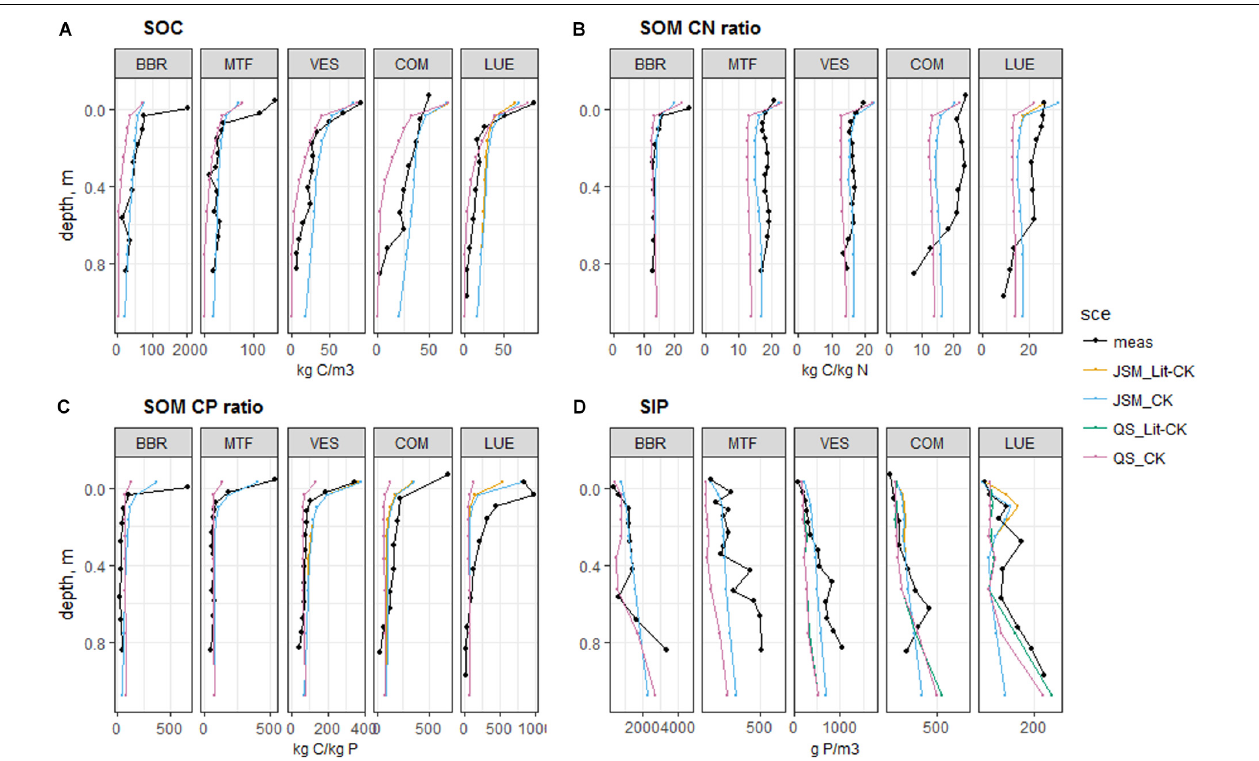
FIGURE 2 | Simulated and observed (A) SOC content, (B) C:N ratio in SOM, (C) C:P ratio in SOM, (D) SIP content at the study sites up to 1 m soil depth. Black lines and dots: observations; colored lines and dots: simulated mean values by control (CK) and equal-litter control (Lit-CK) treatments. Simulated means were calculated using data from the last 10 years of model experiments.